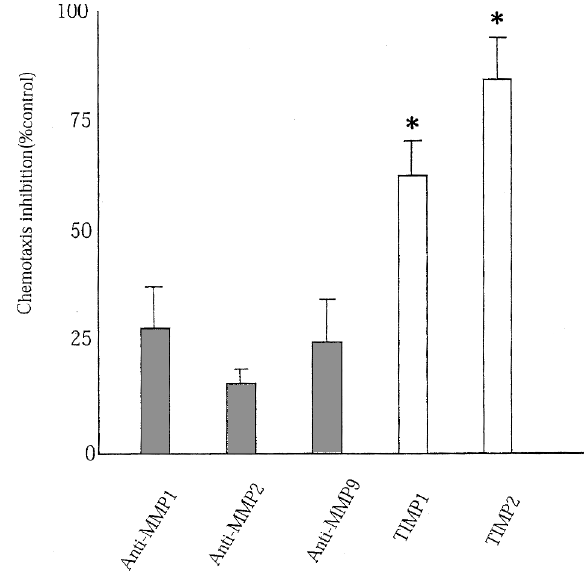
FIG. 4. Effect of anti-MMP1, anti-MMP2, anti-MMP9, TIMP-1 and TIMP-2 on PDGF-induced chemotaxis of fibroblasts. Data are shown as the means ±s.e.mean. Statistical difference compared to responses in the presence of the same subtype of each IgG at a p < 0.05